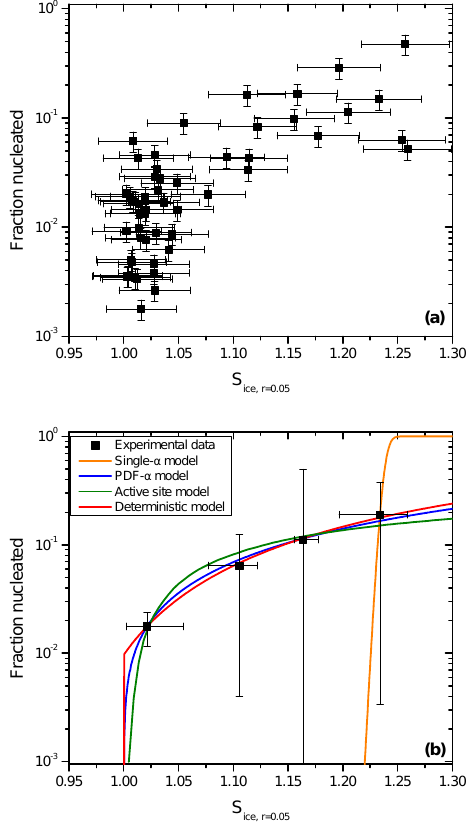
Fig. 6. Fraction of particles nucleated as a function of S ice , r = 0 . 05 for illite. Panel (a) shows nucleated fraction for the individual experimental results. The y-error was calculated from the uncer- tainty in the value of ¯ D g . The x-error represents the uncertainty in S ice , r = 0 . 05 . Panel (b) shows the average nucleated fraction calcu- lated for four size bins. The range of the data points in each bin is given as the horizontal error and data points represent the average of the S ice , r = 0 . 05 values within each bin. The y-error bar in panel (b) represents the 95% confidence interval of the average nucleated fraction. Fits are shown for the single- α , PDF- α , active site, and deterministic